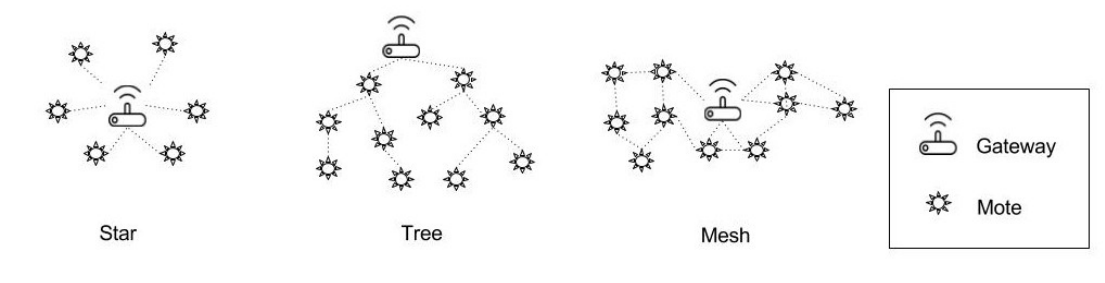
Figure 2. WSN communication